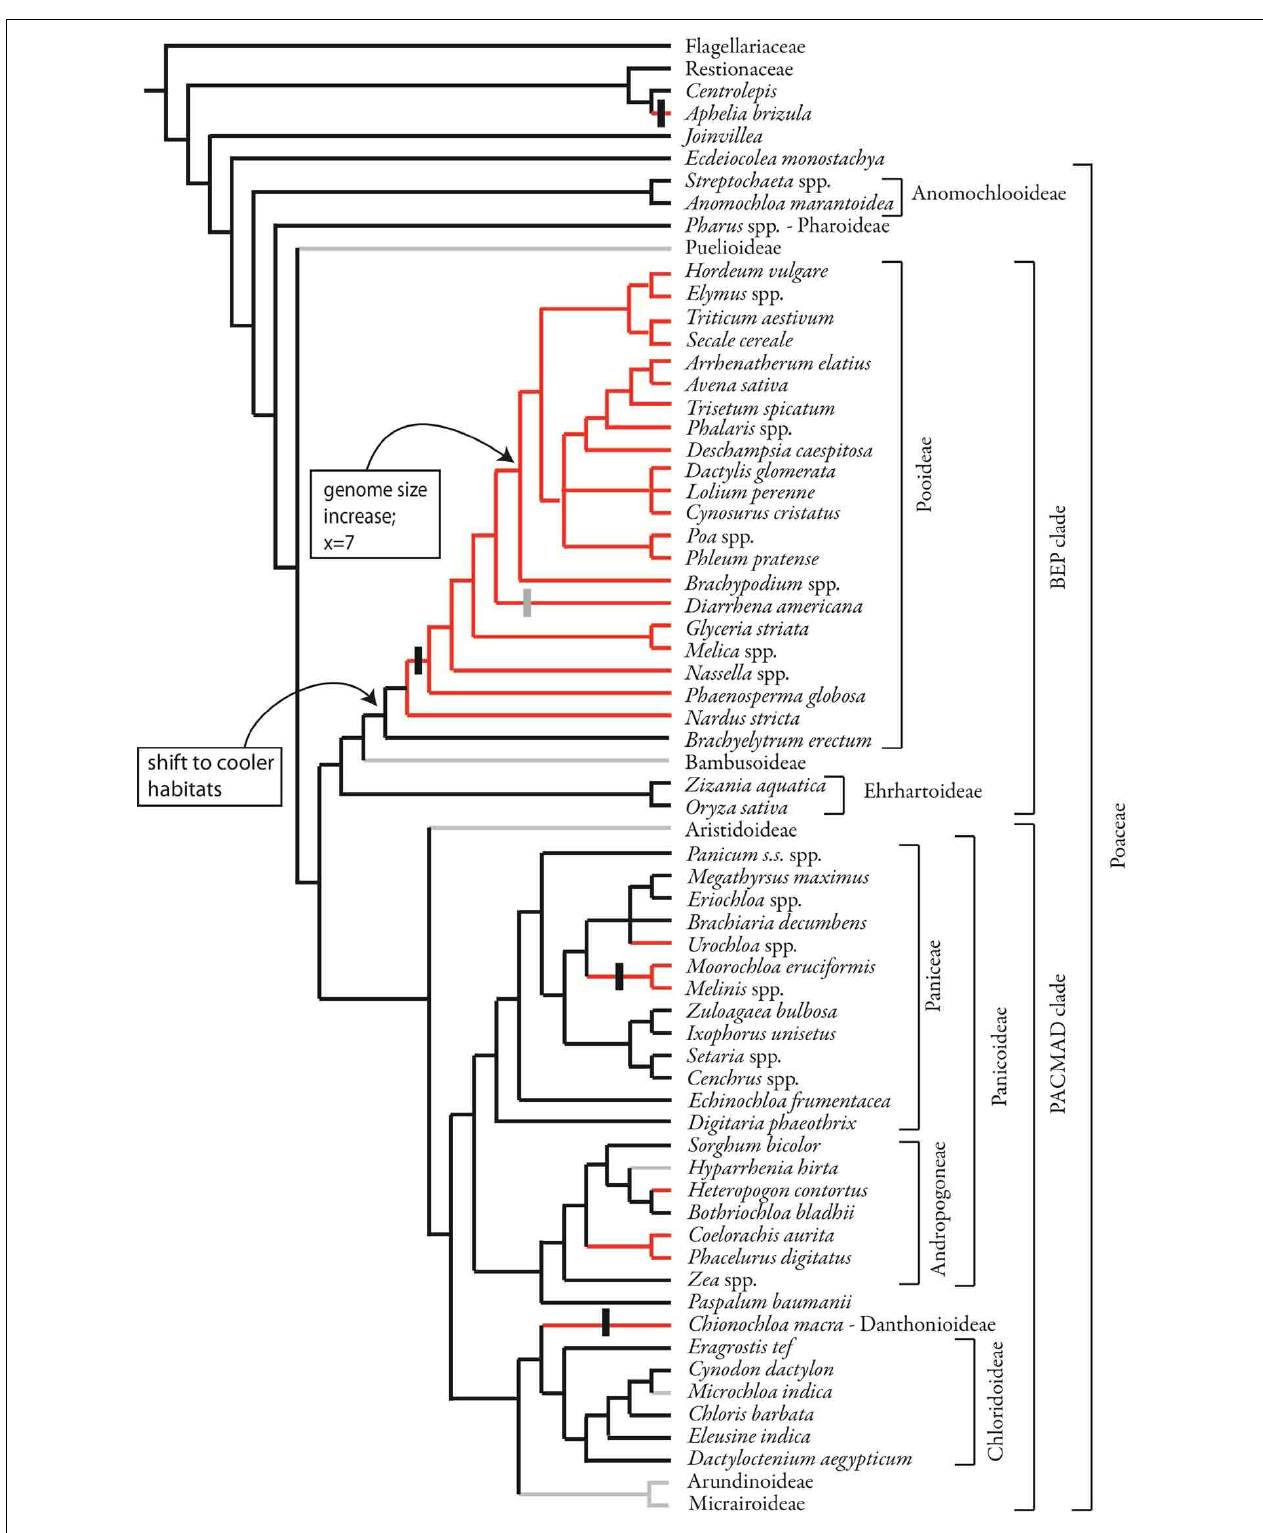
FIGURE 11 | Phylogenetic distribution of inflorescence phyllotaxis, including data from this study and from the literature. Parsimony optimization is shown but ML optimization is similar. Species relationships based on Quintanar et al. (2007), Saarela et al. (2010),